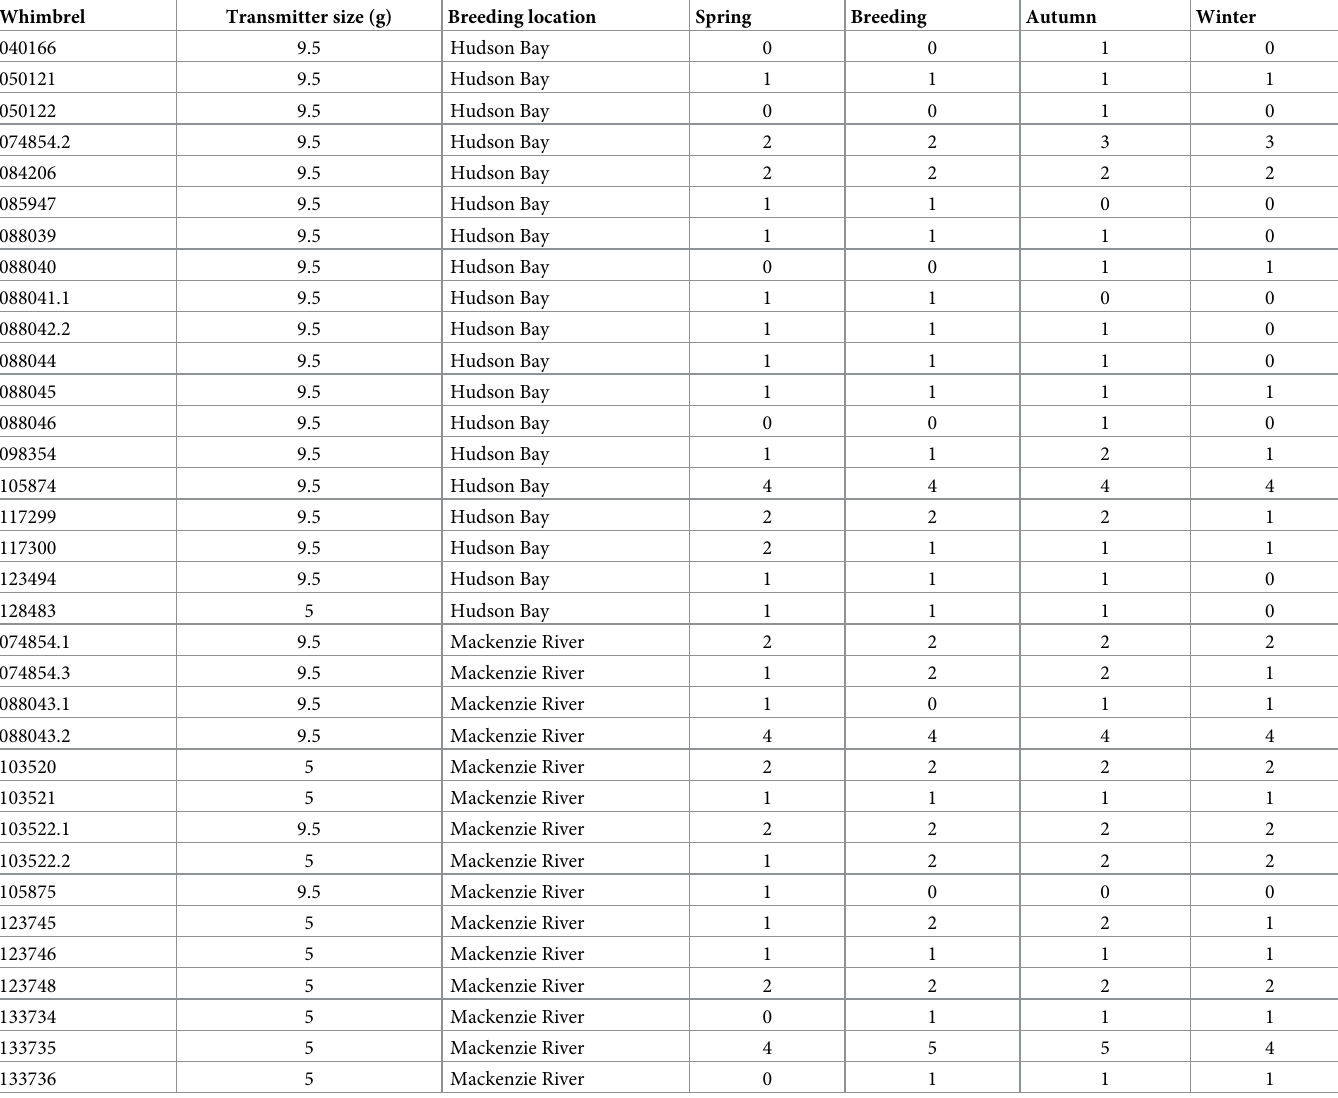
Table 1. Summary information for adult Whimbrels tracked with satellite transmitters throughout the Western Atlantic Flyway (2008–2018).